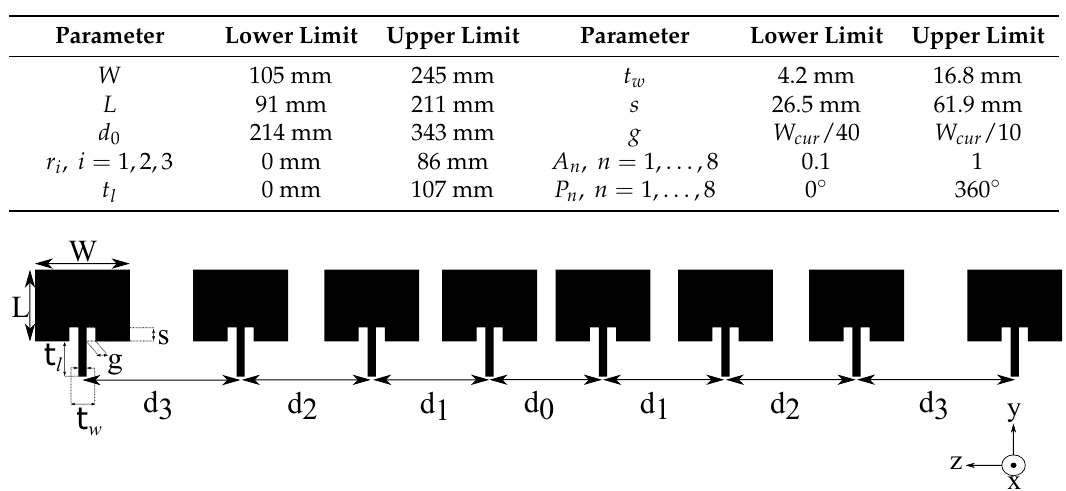
Table 1. Optimization Parameter Limits.